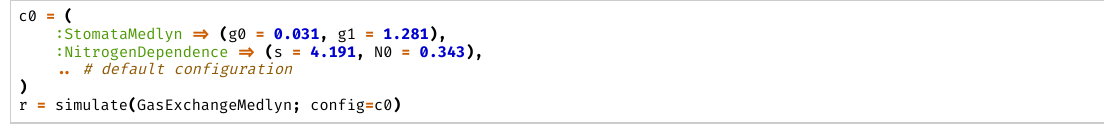
Figure A3. Script for running a coupled gas-exchange model with Medlyn stomatal conductance submodel. Parameter values as listed in Table A2 are included in the baseline configuration c0 used by simulate()